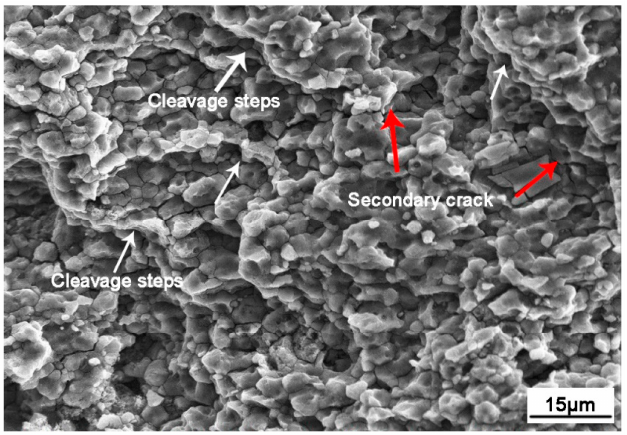
Figure 16. Morphology of the final fracture zone.